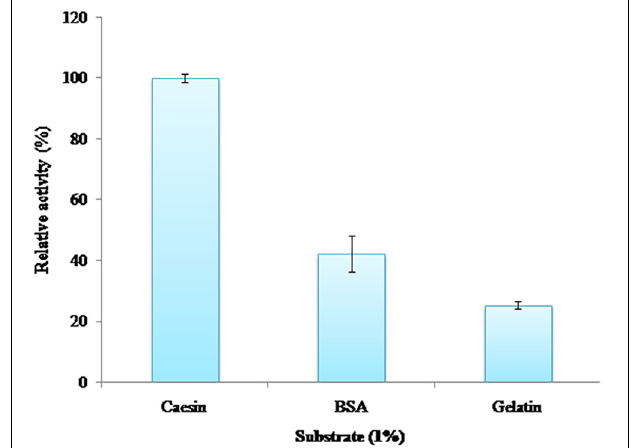
FIGURE 4 | Substrate specificity of